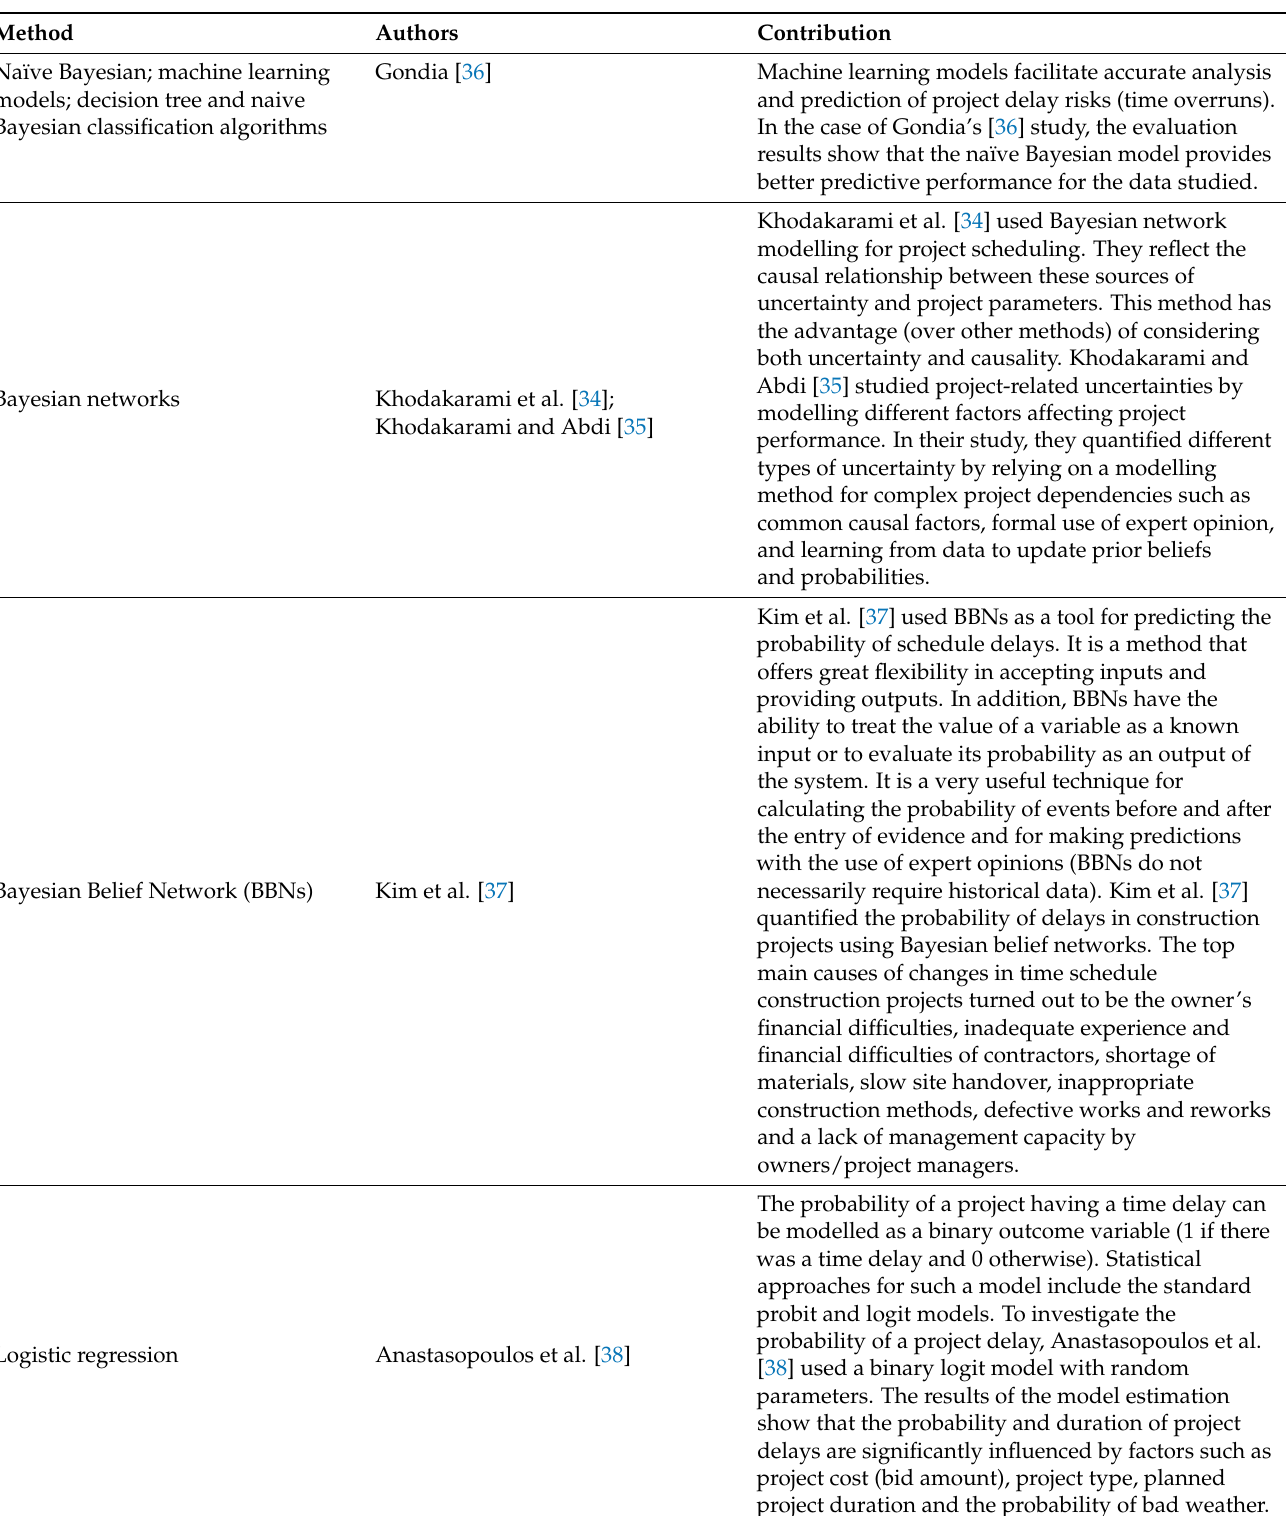
Table 1. Different methods addressing time schedule management in construction